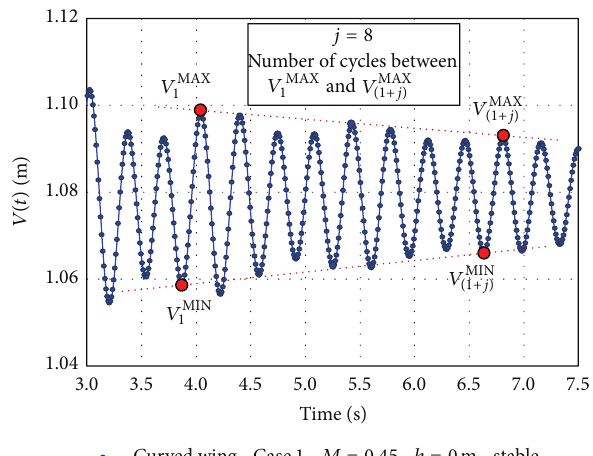
Figure 6: Time history of LE vertical displacement of the curved wing (Case 1 : sea level, see Figure 8).